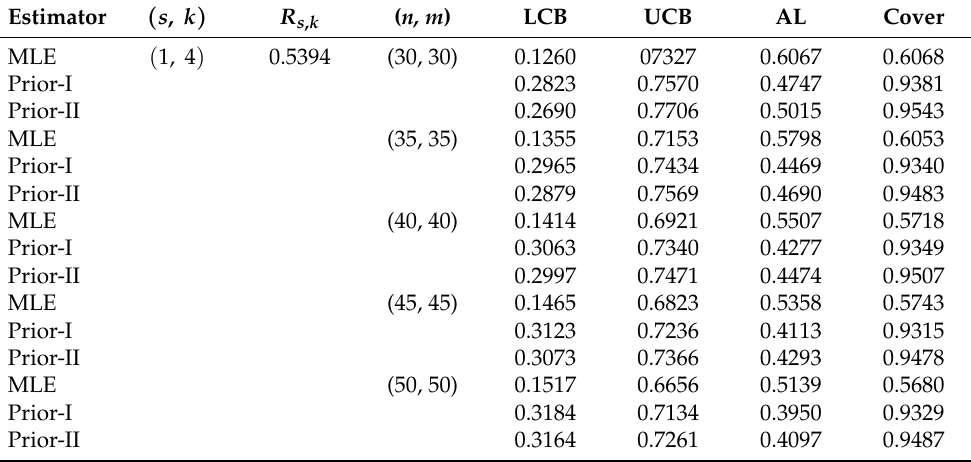
Table 6. The 95% confidence intervals of R s , k for Case 1, ( α , λ 1 , β , λ 2 ) = ( 2, 2, 2, 3 ) and T =